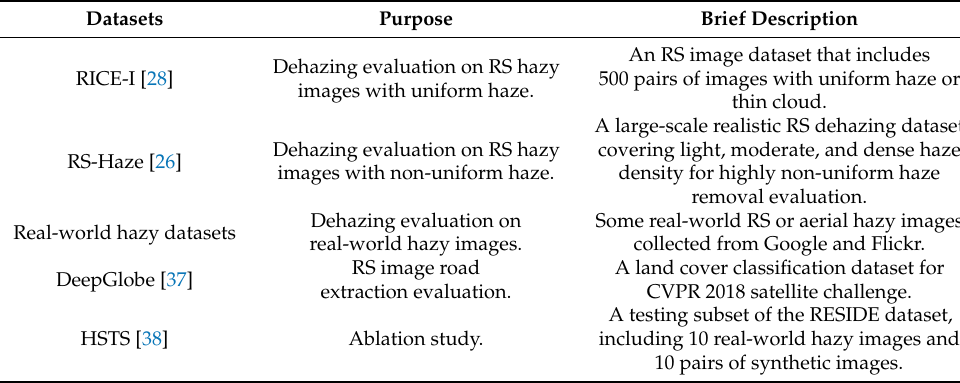
Table 1. Datasets that are used in the experiments. Datasets Purpose Brief Description An RS image dataset that includes Dehazing evaluation on RS hazy 500 pairs of images with uniform haze or RICE-I [28] images with uniform haze. thin cloud. A large-scale realistic RS dehazing dataset Dehazing evaluation on RS hazy covering light, moderate, and dense haze RS-Haze [26] images with non-uniform haze. density for highly non-uniform haze removal